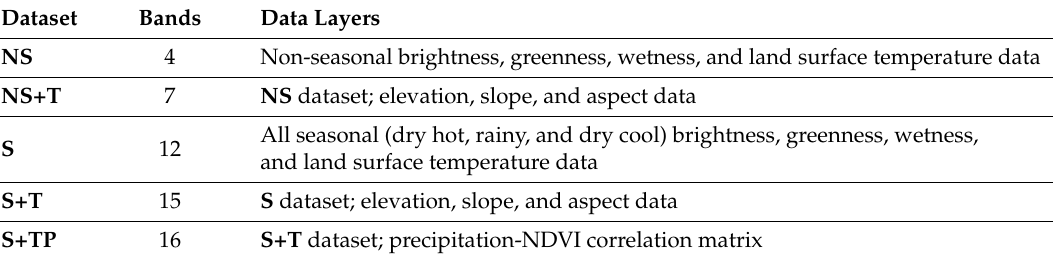
Table 3. Datasets for Comparison and